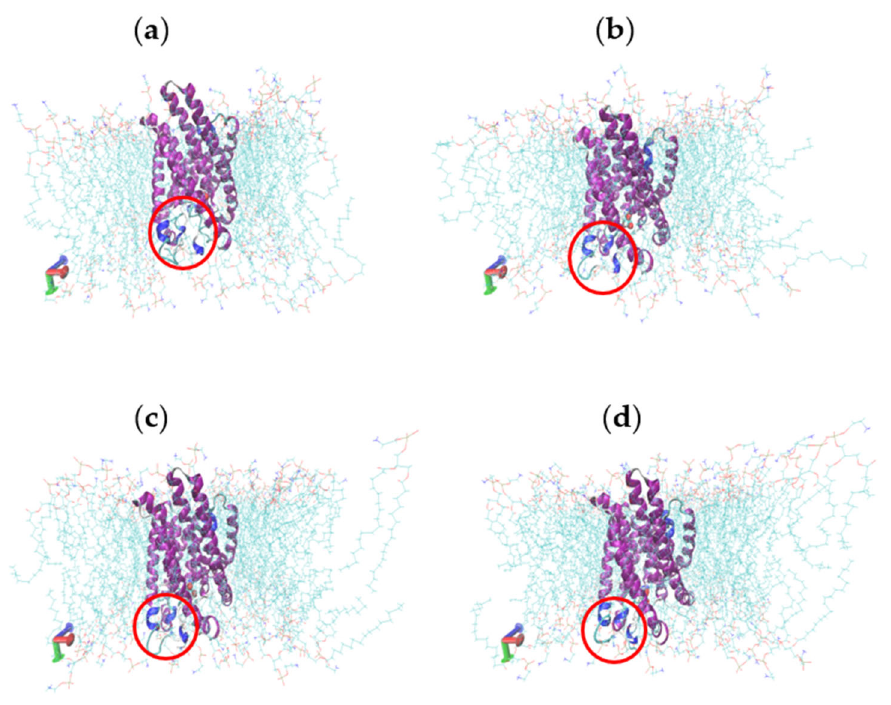
Figure 9. The binding conformations and molecular interaction of MT-MAL system versus MD simulation course. ( a ) 0 ns, ( b ) 10 ns, ( c ) 20 ns, ( d ) 30 ns, MT was in cartoon, membrane in line, ligand in a